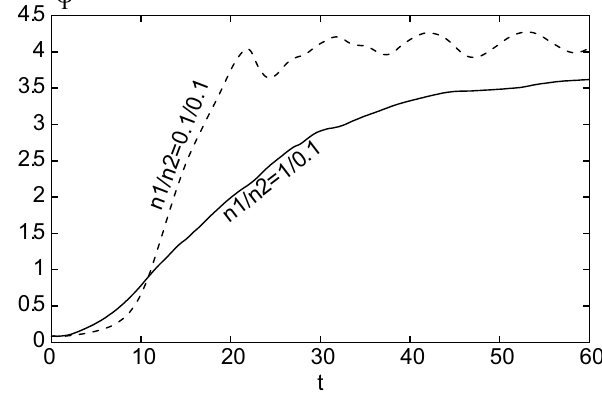
Fig. 11. Comparison between the present case (solid black), and the symmetric n 1 / n 2 =0.1/0.1 case (dashed black). Reconnected mag- netic flux 9 as a function of time is shown. 9 of the n 1 / n 2 =0.1/0.1 case shows faster reconnection rate and larger saturation